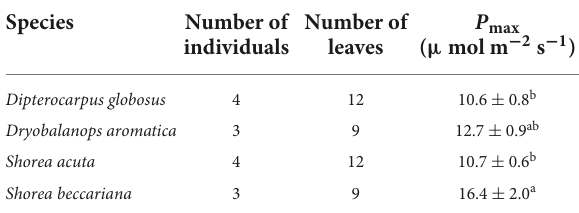
TABLE 7 Results of interspecific comparison of P max in heterobaric canopy species.